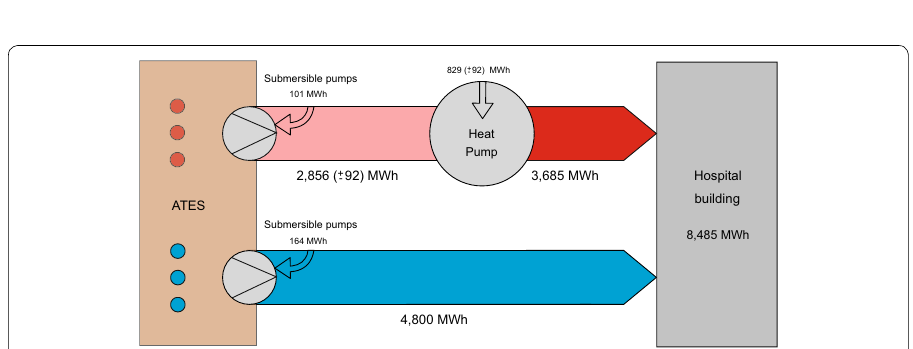
Fig. 3 Energy flows of the considered ATES system for the heating and cooling supply